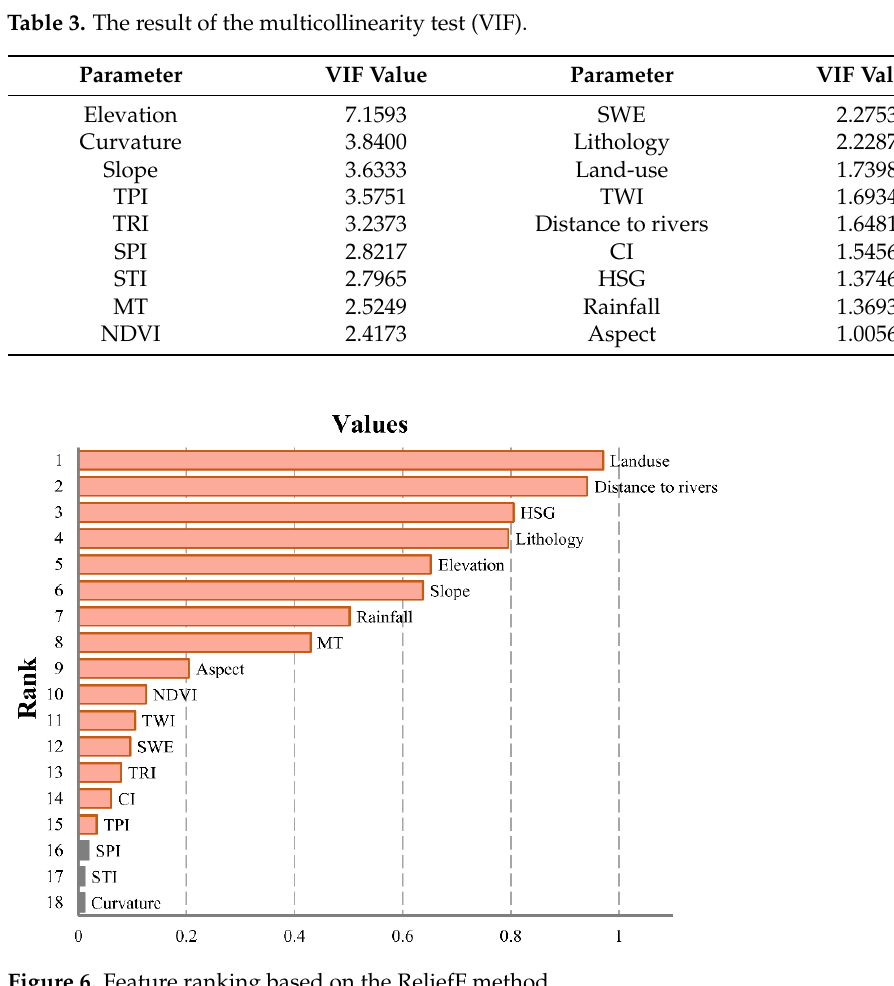
Figure 6. Feature ranking based on the ReliefF method.